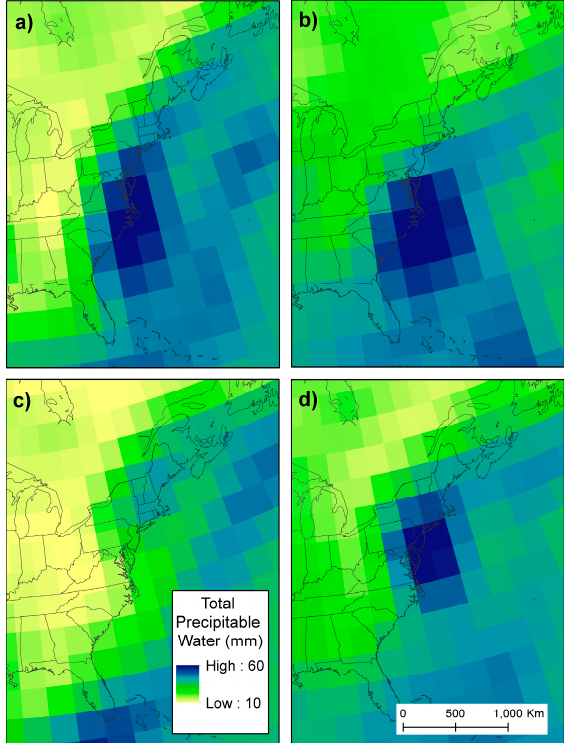
Figure 6. Precipitable water (mm) averaged over the day of landfall over North Carolina for ( a ) Floyd, and ( b ) Irene, and the day after landfall for ( c ) Floyd and ( d ) Irene. and ( b ) Irene, and the day after landfall for ( c ) Floyd and ( d )